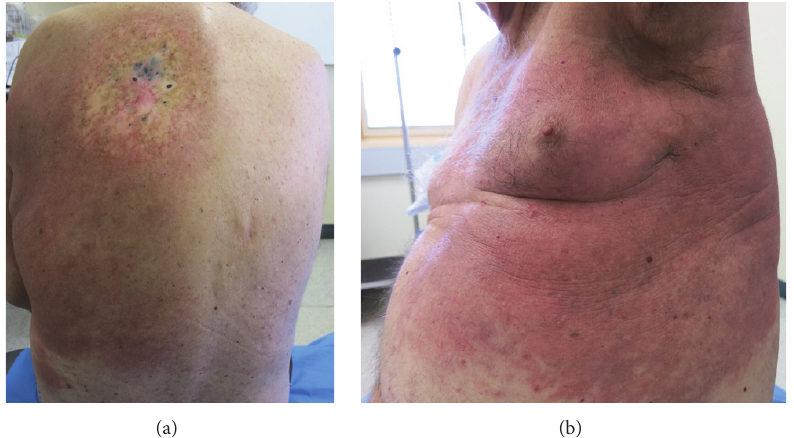
Figure 1: (a) Erythematous cutaneous reactions on left upper back spreading to lower back and to (b) axilla and flank.